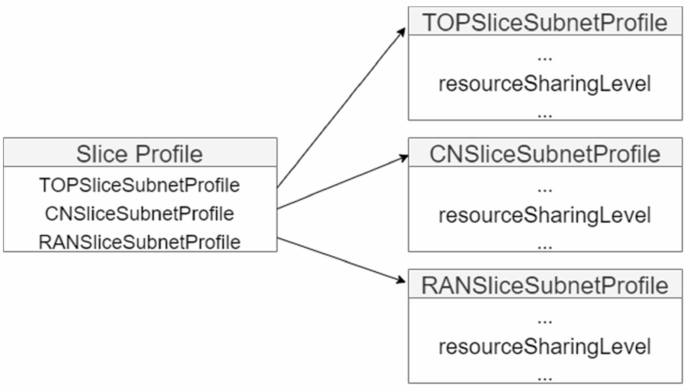
Figure 4. Network slice modelling by the 3GPP. Note: TopSliceSubnetProfile represents the top slice network slice